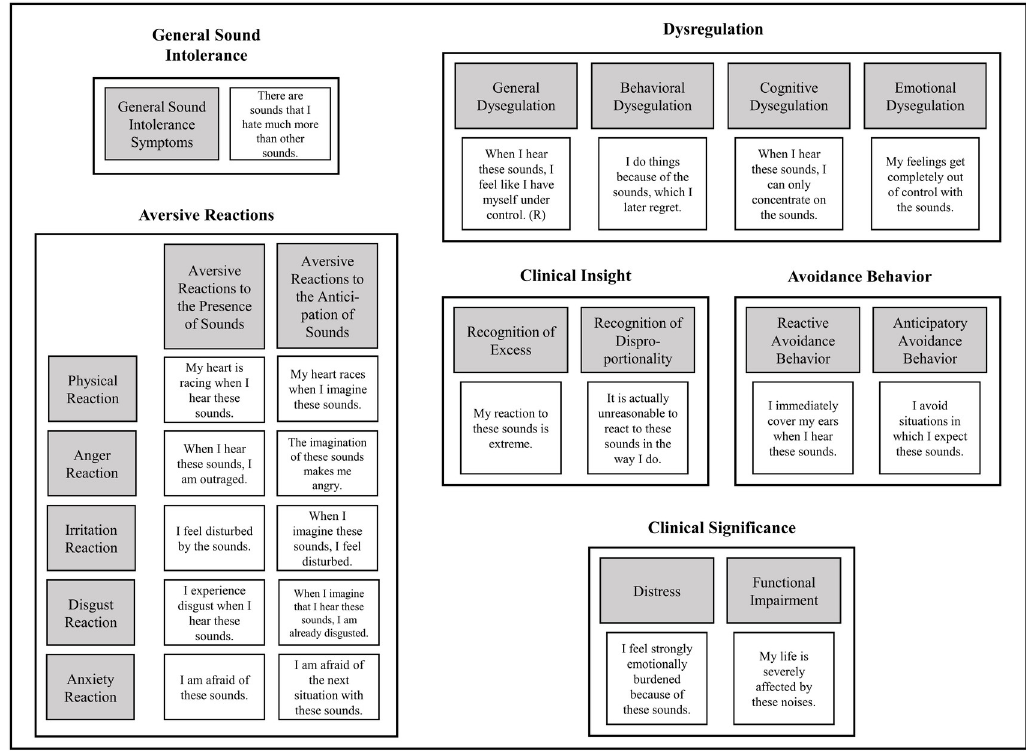
Fig 1. Outline of the symptom-oriented scales and exemplary